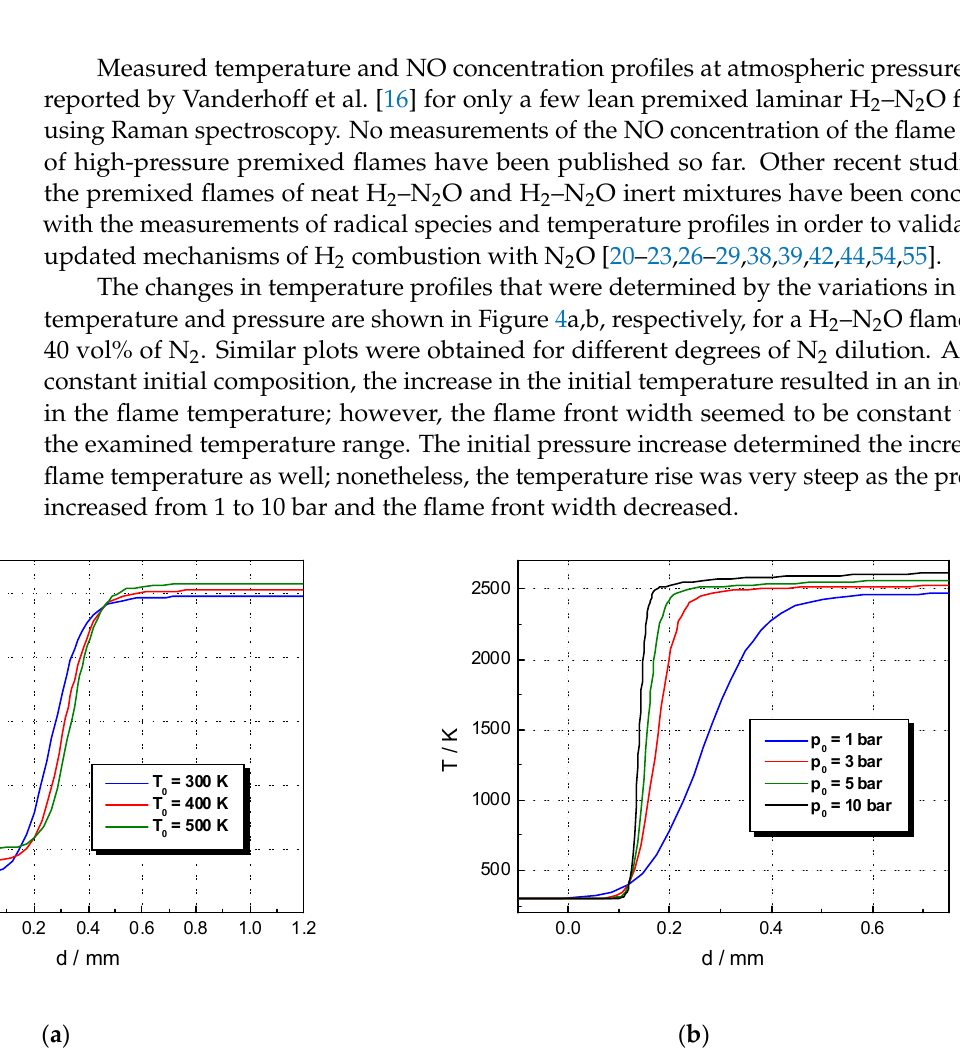
Figure 4. Temperature profiles of the flame front of a N 2 –diluted stoichiometric H 2 –N 2 O flame (N 2 = 40 vol%): ( a ) mixtures at 1 bar and various initial temperatures; ( b ) mixtures at 300 K and various initial pressures.